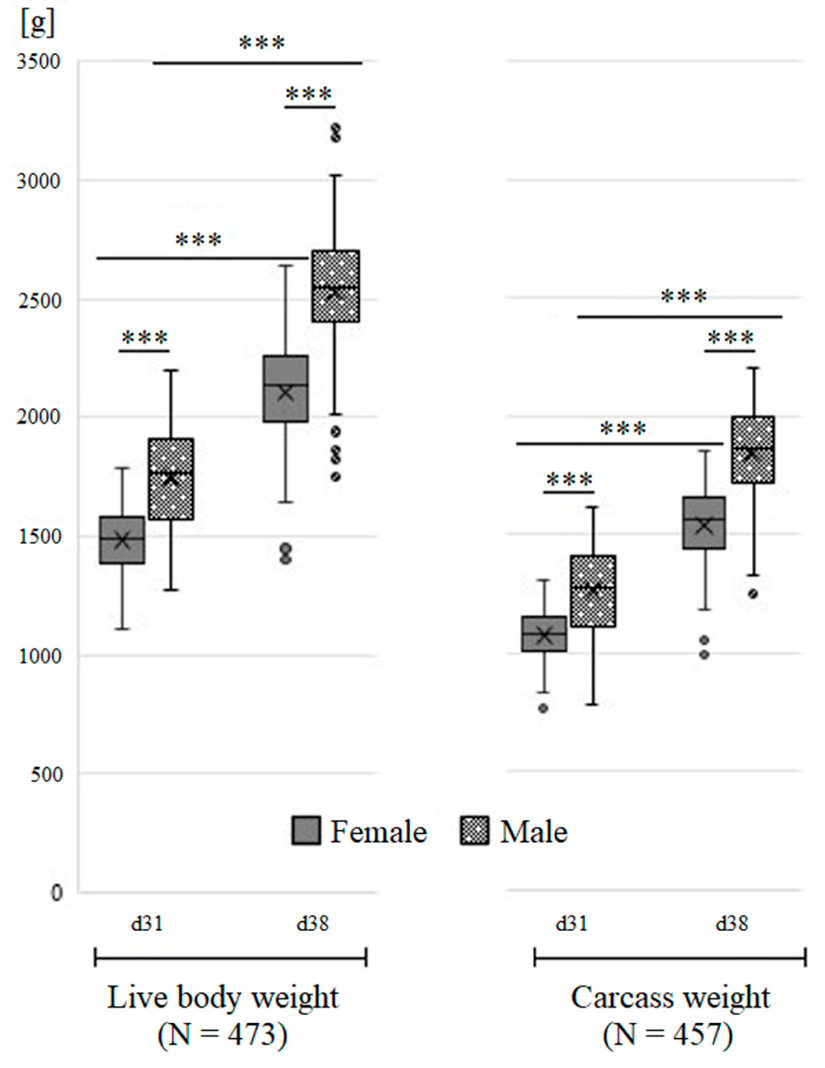
Figure 2. Effect of the interaction between sex (females presented in gray, males presented with patterns) and age at slaughter (day 31, day 38) on live body weight and carcass weight. Results are presented as boxplots (data range, median, lower quartile, and upper quartile; outliers are included in the graph as dots); significant differences between sex and age are marked by asterisks: *** p < 0.001 (Tukey–Kramer tests).